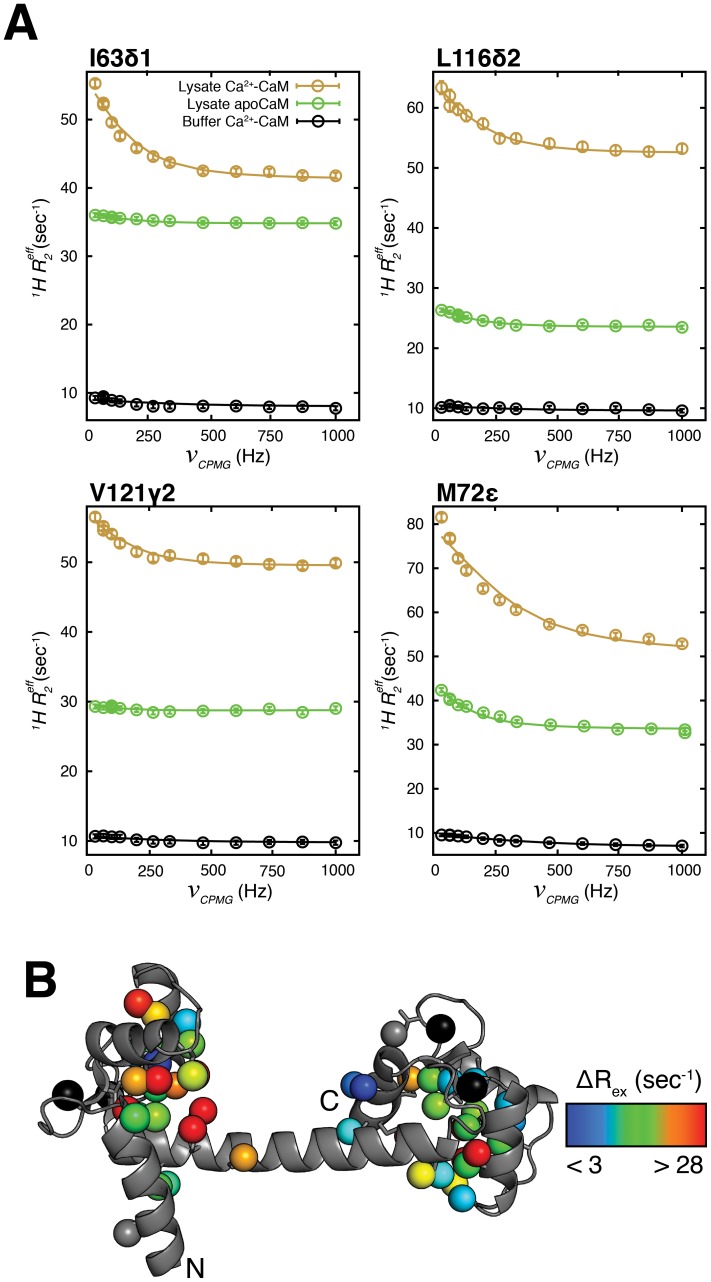
Pervasive chemical exchange in lysate Ca2+-CaM.(A) Representative 1H CPMG relaxation dispersion profiles from I63δ1, L116δ2, V121γ1 and M72ε methyl groups of buffer Ca2+-CaM (black) and lysate Ca2+-CaM, 6 mM Ca2+ (brown). For comparison, dispersion curves are also shown for lysate apoCaM (green). (B) Structure of Ca2+-CaM (3CLN) [40] with methyl groups color coded according to 1H ΔRex values. Methyl groups with 1H ΔRex <3 sec−
1 are colored gray. The four Ca2+ ions are shown as black spheres.